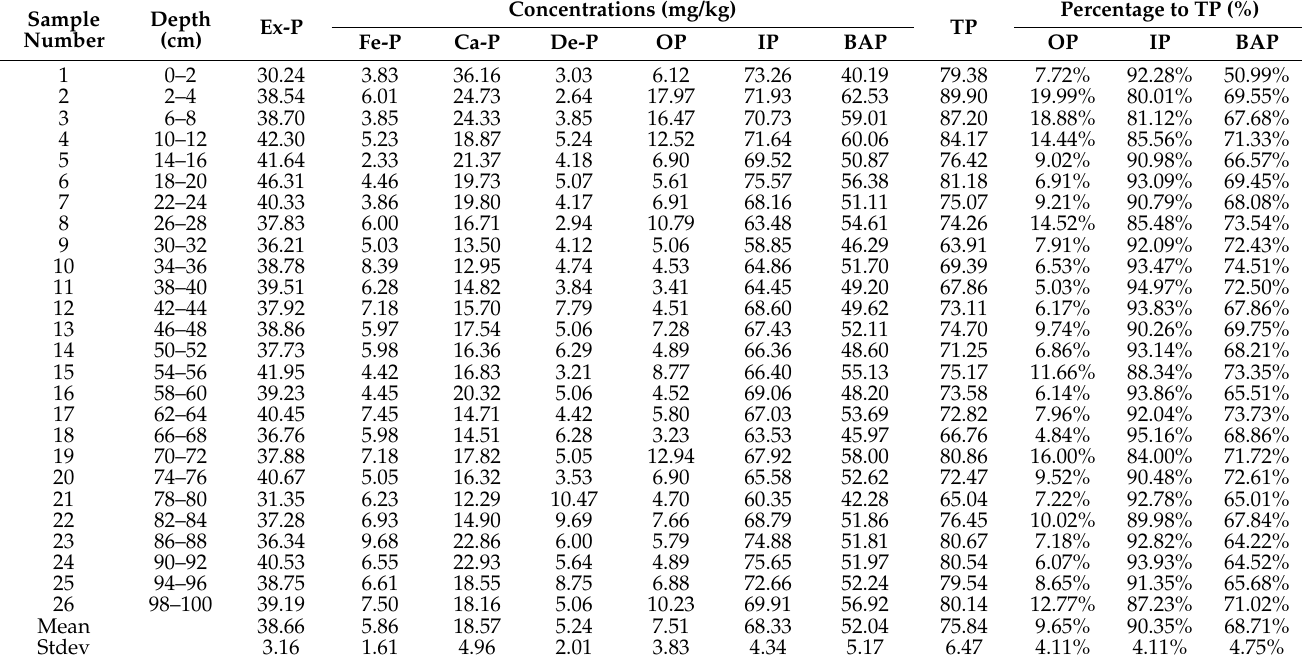
Table A2. Sampling site M1-S1.